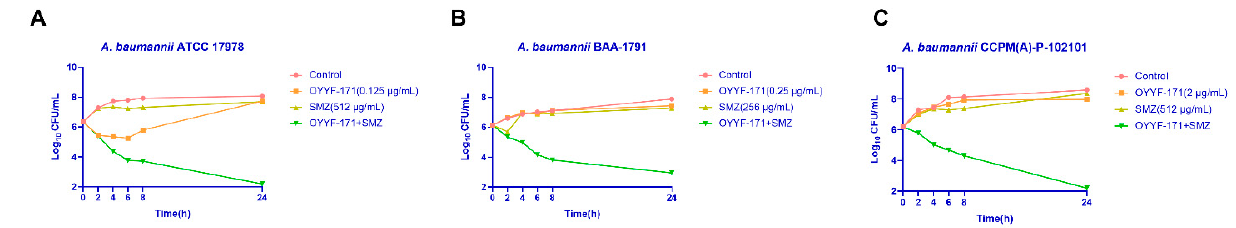
Figure 5. Time-killing curve of SMZ and OYYF-171 used alone and in combination against A. bau- mannii isolates.